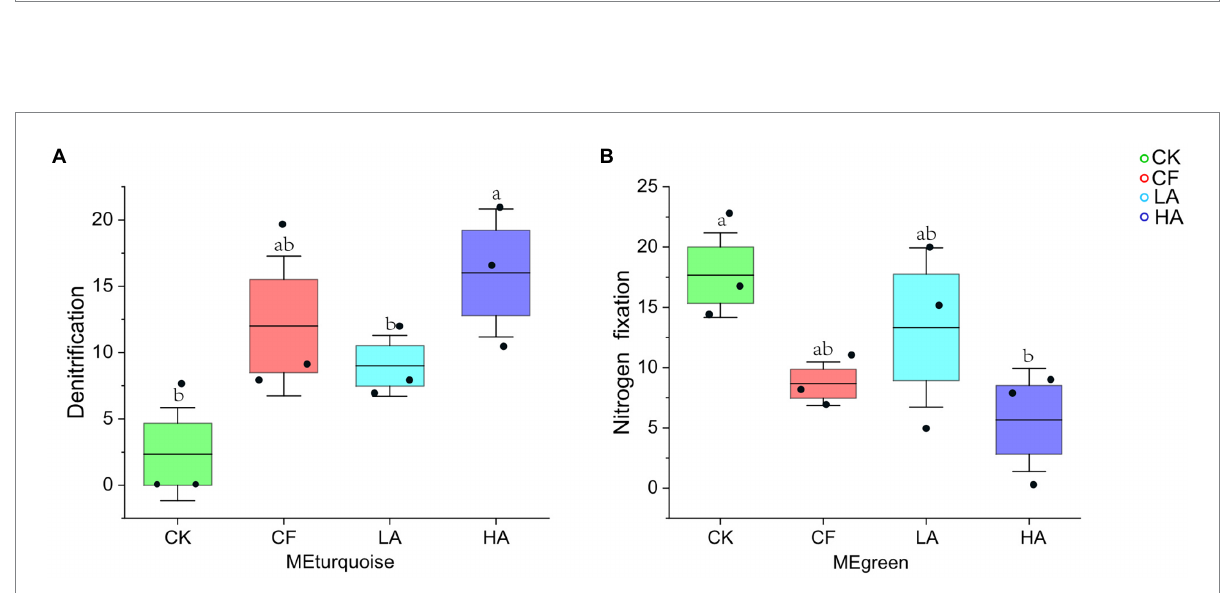
FIGURE 5 Functional abundance of ecological clusters. (A) Abundance of denitrification function in MEturquoise. (B) Abundance of N fixation function in MEgreen. Different labeled letters indicate significant differences between different treatments according to one-way ANOVA with Duncan’s multiple range tests ( p <